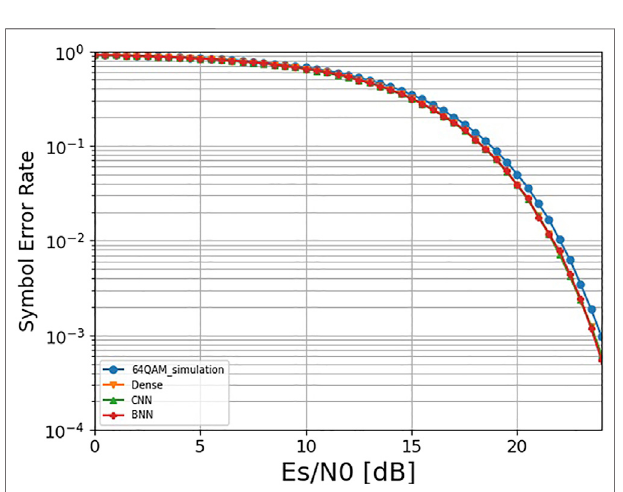
FIGURE 4 | Performance comparison when transmitting symbols.